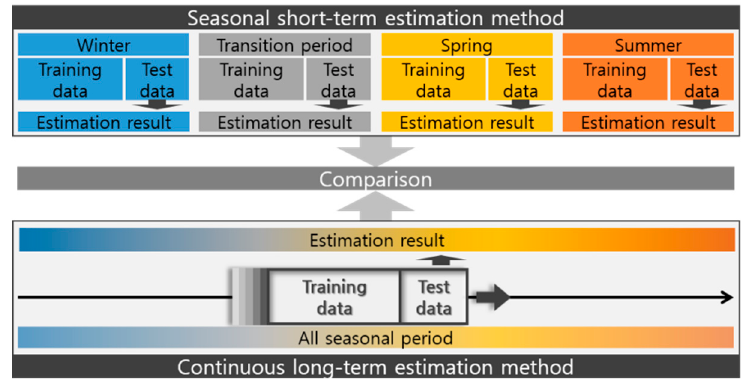
Figure 3. Schematic diagram of the comparison process between long-term and short-term data based occupancy estimation performances.